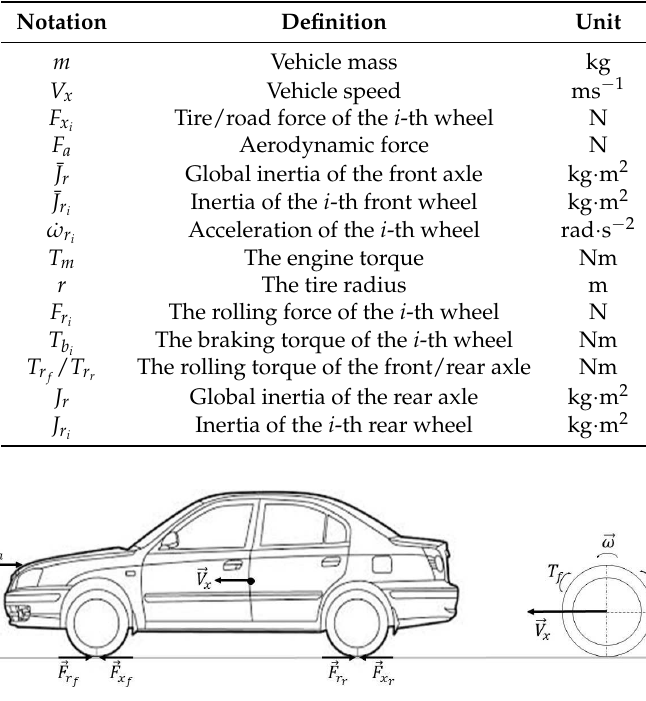
Figure 2. Vehicle longitudinal